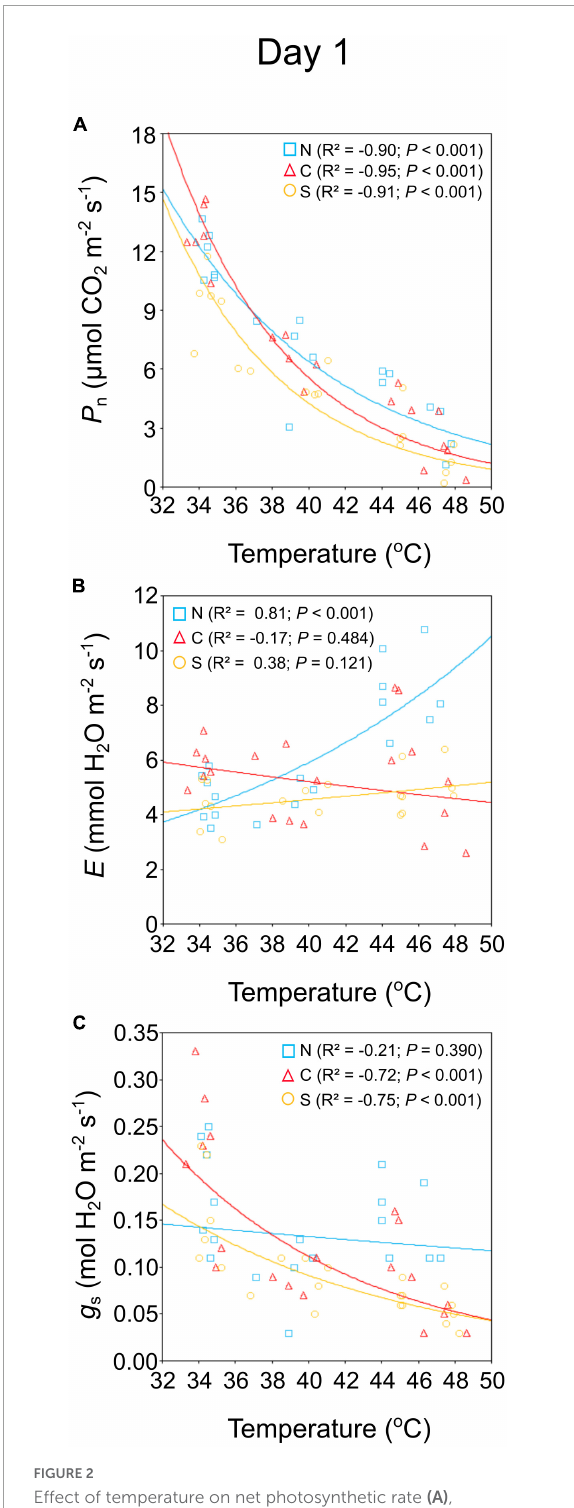
FIGURE2 Effect of temperature on net photosynthetic rate (A) , transpiration rate (B) , and stomatal conductance (C) of 6-month-old Castanea sativa seedlings from the northern (N, blue squares), central (C, red triangles), and southern (S, yellow circles) populations. The variance explained ( R 2 ), and the significance ( P ) of the models are